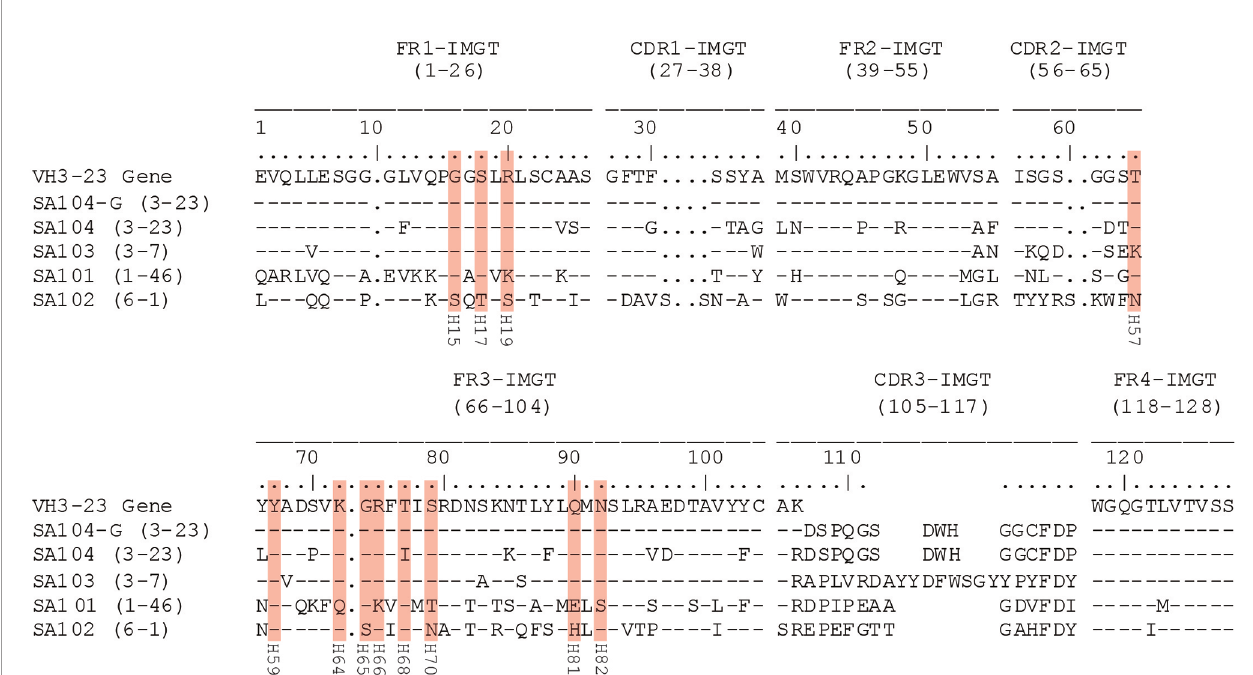
FIGURE 5 | Alignment of heavy chain variable region sequences of mAbs. The deduced amino acid sequences of recombinant monoclonal IgG antibodies are compared to the VH3-23 germline gene sequence using IMGT-number convention. SpA contact residues with the VH region of the antibodies are highlighted with red boxes with the original numbering used in de fi ning the VH3 Fab-SpA binding interaction below each residue. The natural variation in the mAb SA103, T57K is permissive of the binding interaction